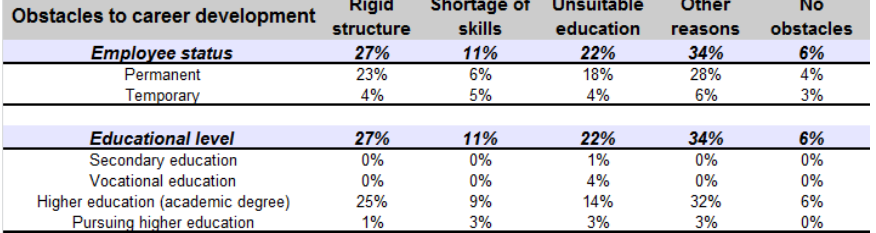
Table 23 - Obstacles to career development versus employee